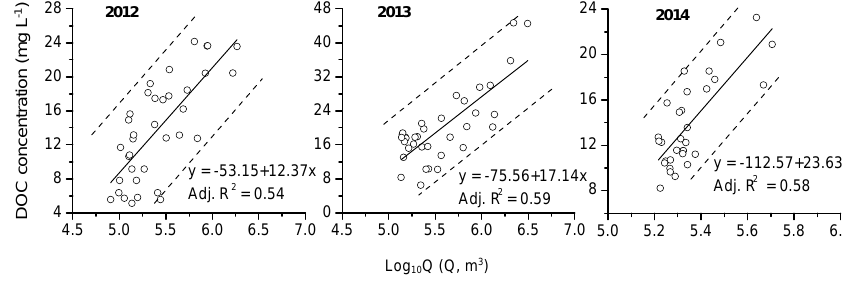
Figure 4. Relationships between discharge ( Q ) and the DOC concentrations for the 2012–2014 sampling